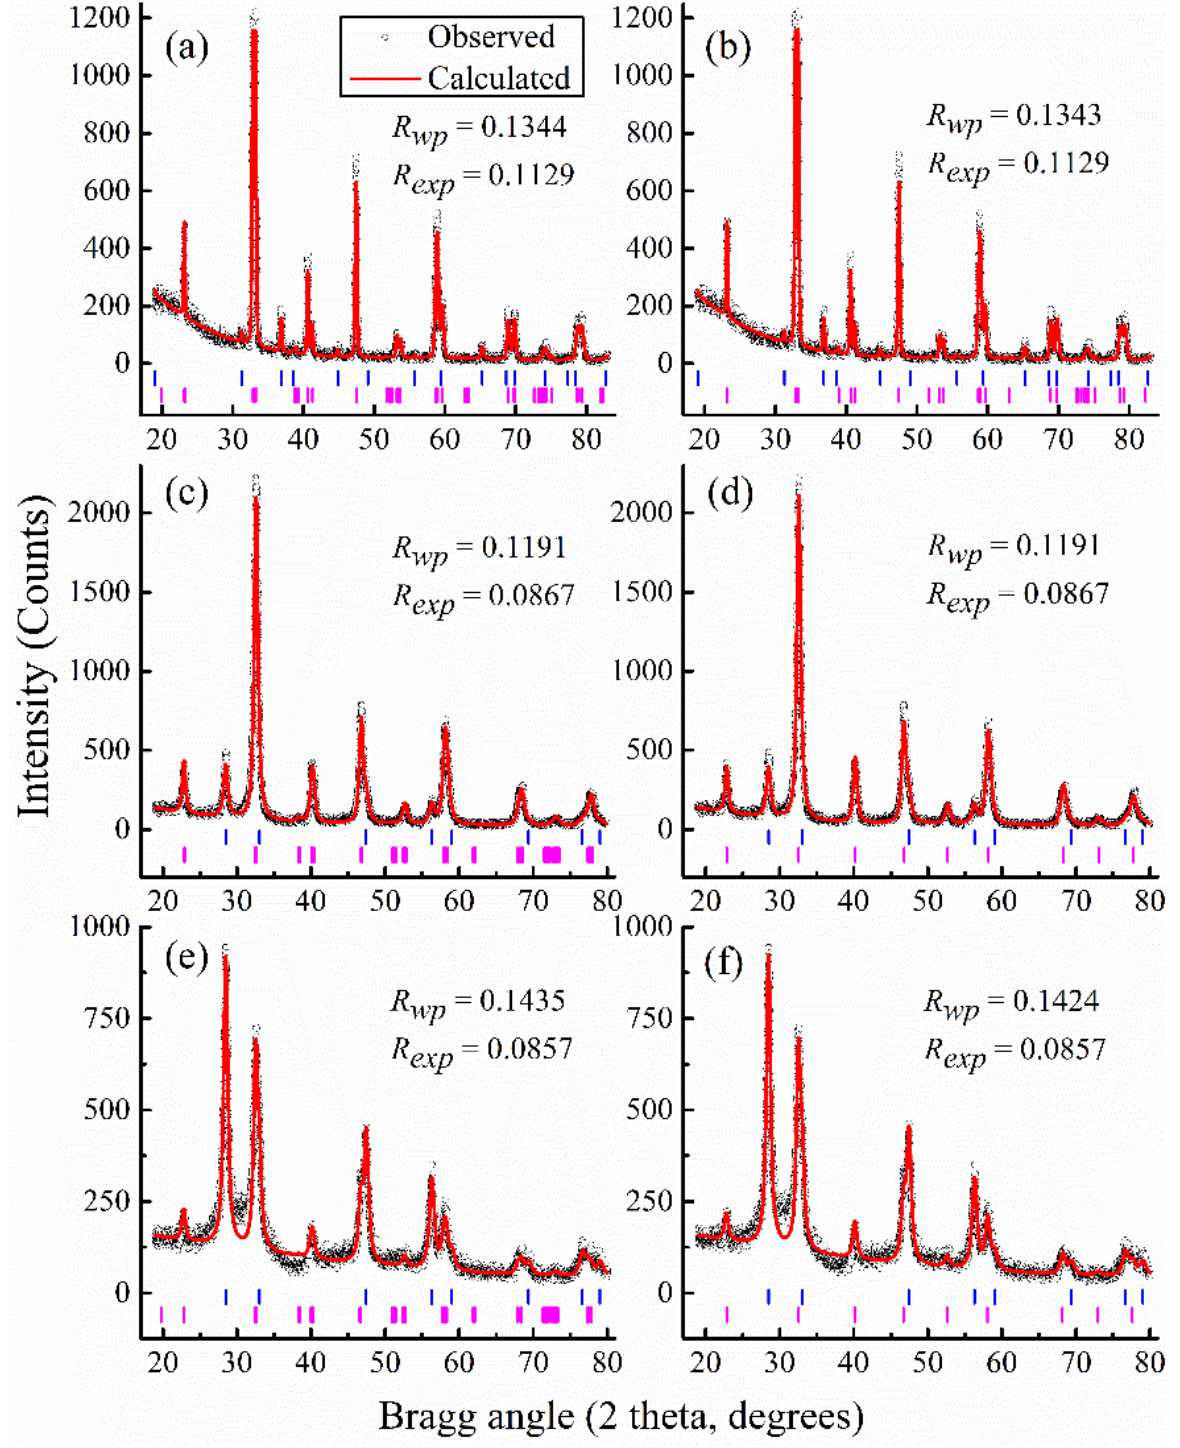
Figure 2. Rietveld refinement patterns of XRD data for La 1 − x Ce x CoO 3 : ( a , b ) x = 0, ( c , d ) x = 0.2, and ( e , f ) x = 0.4. Vertical lines at the bottom of each sub-figure represent positions of Bragg peaks of the main phase (lower lines) and the secondary phase (upper lines). Phase and [space group] for each sub-figure are as follows: ( a ) LaCoO 3 [ I12/a1 ] + Co 3 O 4 [ Fd-3m:1 ], ( b ) LaCoO 3 [ R-3c: R ] + Co 3 O 4 [ Fd-3m:1 ], ( c ) La 3 + Ce 4 + Co 3 + Co 2 + O 3 [ I12/a1 ] + CeO 2 [ Fm-3m ], ( d ) La 3 + Ce 4 + Co 3 + Co 2 + O 3 [ Pm-3m ] + CeO 2 [ 0.8 0.2 0.8 0.2 0.8 0.2 0.8 0.2